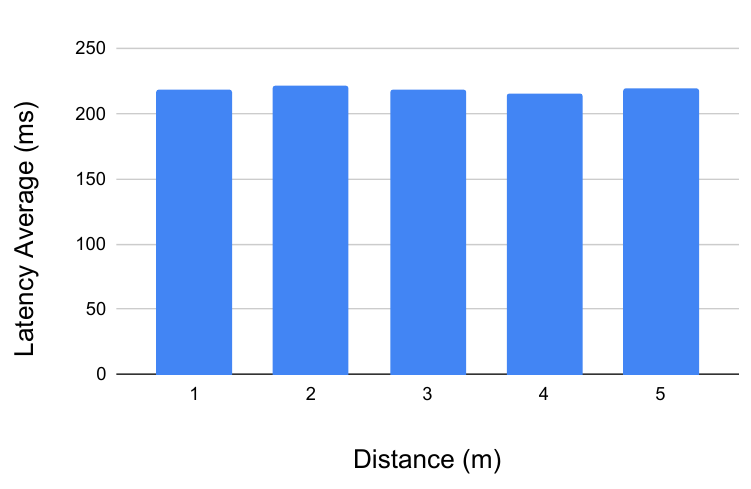
Figure 32. Latency results obtained by sending a «get state» request to the the robot via Bluetooth from the Mobile Android